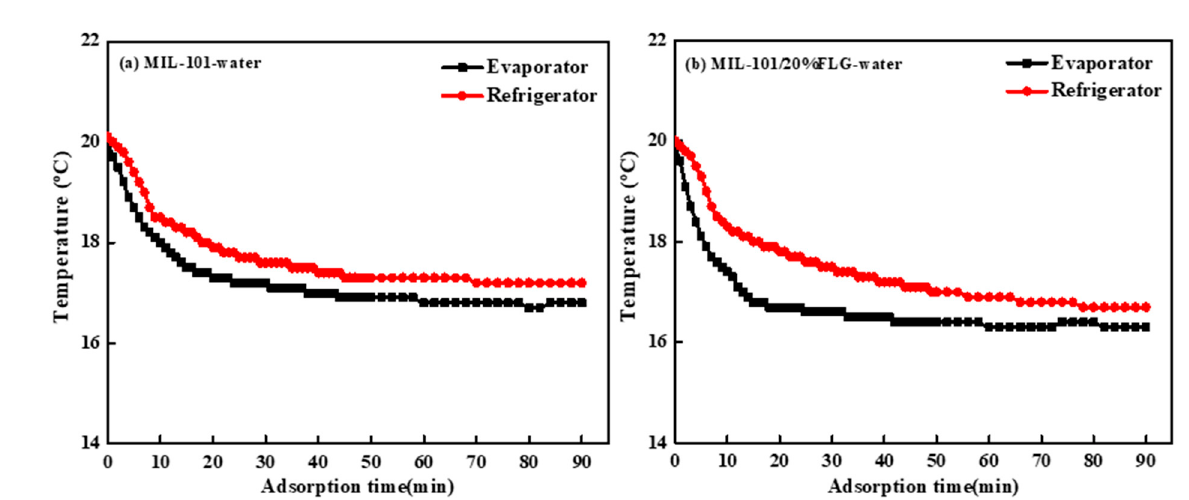
Figure 11. Temperature characteristic curves of ( a ) MIL-101-water and ( b ) MIL-101/20%FLG-water working pairs during the cooling process. Table 1. Cooling capacity, SCP and COP of MIL-101-water and MIL-101/20%FLG-water working pairs for an adsorption water chiller